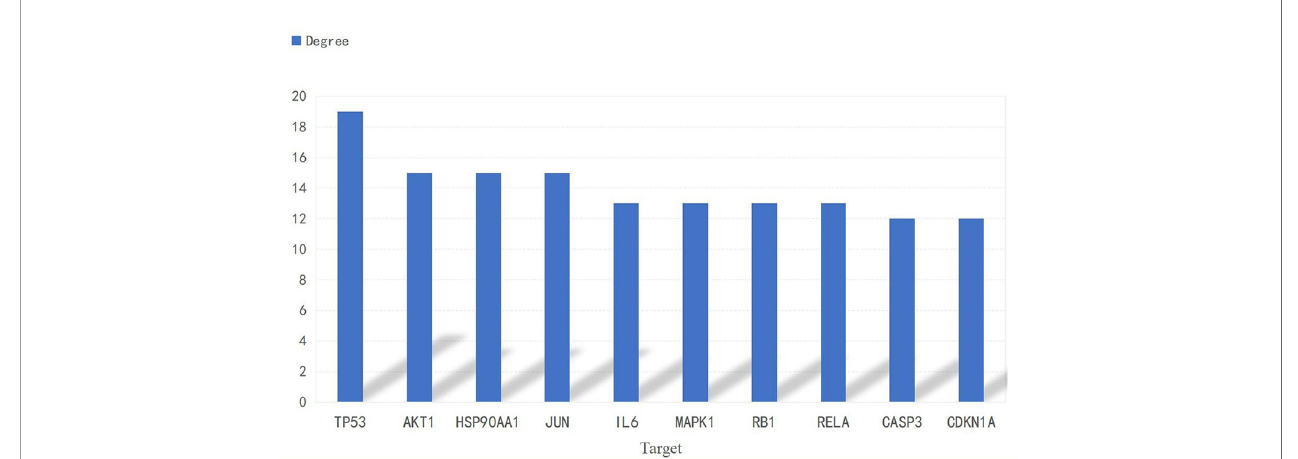
FIGURE 5 | Histogram of the adjacent target number.